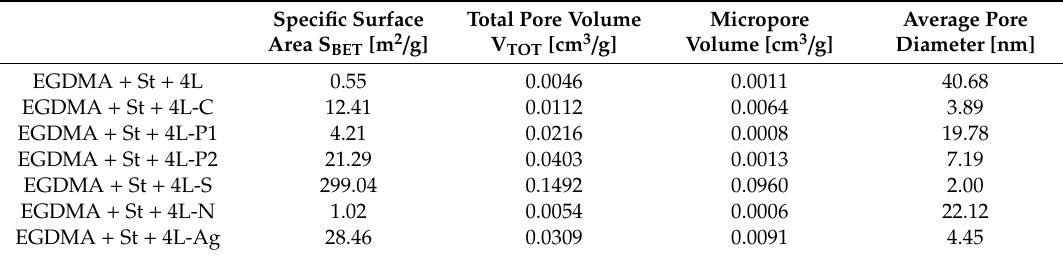
Table 7. Parameters of the porous structures of the studied copolymers.